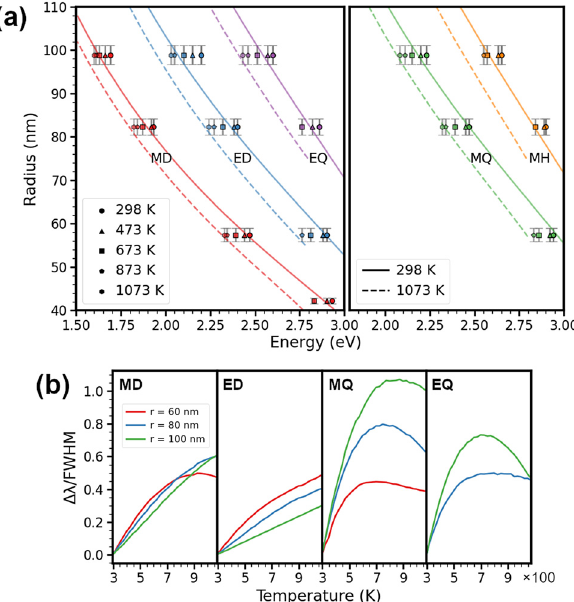
Figure 2: Tunability of Mie resonances. (a) Measured resonance energies as a function of particle radius and temperature for the first five Mie resonances in silicon nanoparticles. The color points represent experimental values, and the color lines show the first maxima of the different Mie scattering coefficients. ED/EQ and MQ/MH resonances are separated into two plots for clarity. (b) Simulated linewidth tunability as a function of temperature for the first four Mie modes supported by silicon nanoparticles with different